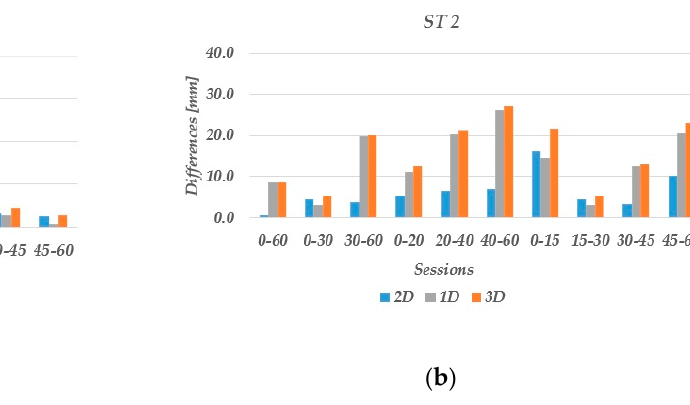
Table 1. Used parameters in the data processing.